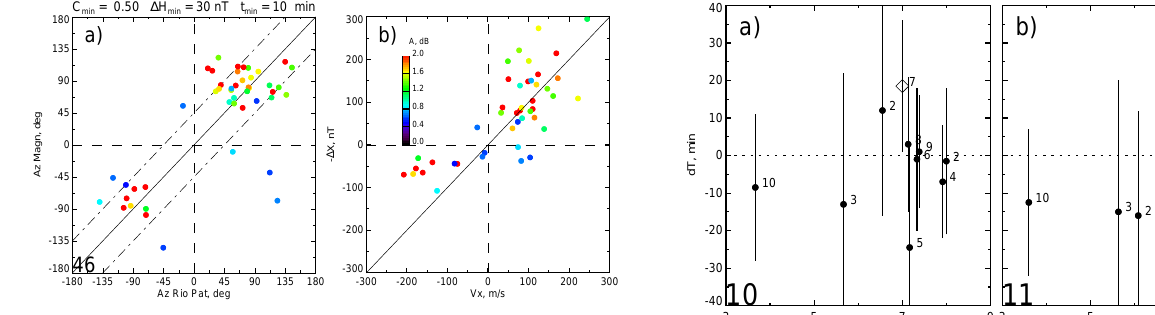
these reversals are given in the last column of Table 1. The drift reversals were also determined from the analysis of the drift direction for successive absorption patches as described below. We first identified successive patches with zonal drifts in opposite directions and above a threshold of 20 ◦ in drift az- imuth magnitude. Only the absorption patches of sufficiently long duration 1t min =7 min and high correlation coefficient (the highest of the two) C min =0.6 were considered here. The absorption patch drift reversal time was then set to the mean of the start time of the first patch t 1 and the end time of the st + t 2 )/ 2. The uncertainty in second patch t 2 , t rev pat ≡ (t 1 st end end − t 1 )/ 2. The re- reversal time in this method was set to (t 2 st end versal time estimates calculated in this method were shown in Fig. 2e by the dotted vertical lines with the uncertainties shown by the dashed vertical lines. To check that the two methods of reversal time calcu- lations (from the keograms and from the absorption im- ages) give comparable results we plotted the time difference t rev keo − t rev pat versus t rev keo in Fig. 5a. The uncertainty in t rev keo was assumed to be zero for the present purpose. Digits near each point indicate the event number from Ta- ble 1. There are 10 (out of 11 total) reversals t rev keo that have a corresponding reversal t rev pat within 30 min. The points are clustered evenly around the horizontal line of ideal coincidence and only one point (7, marked by the diamond) is farther from the zero line than the estimate uncertainty. In panel (b) we compare the reversal times from the mag- netometer data t rev magn (shown by solid vertical lines in Fig. 2e) with the closest reversals t rev pat (dotted lines in Fig. 2e) by plotting the difference between those against t rev magn . Again, with the exception of event 1 all reversals in the electrojet flow had corresponding reversals in absorption patch drift direction. Two reversals (both in magnetometer and riometer data) were identified for event 8, whereas